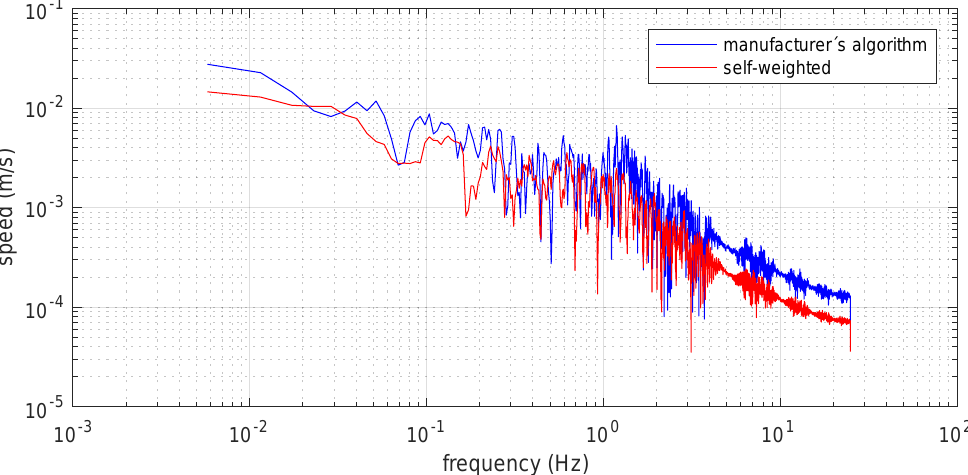
Figure 10. Discrete Fast Fourier Transform of the speed vs. time signal obtained by the test